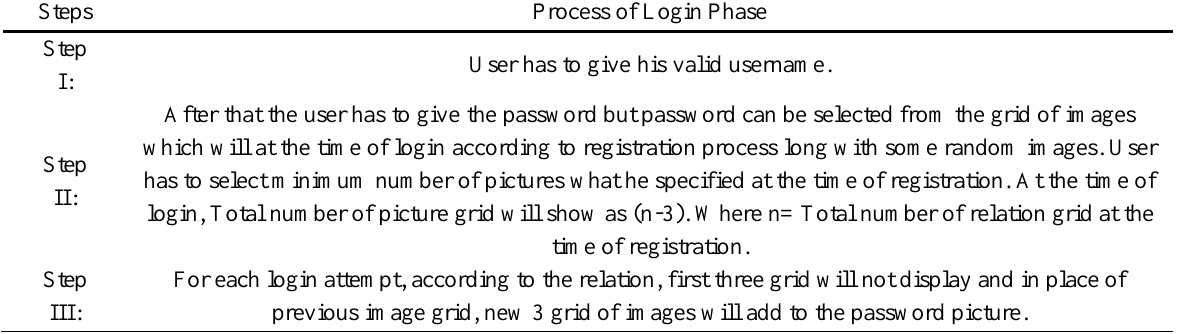
Table 2. Process of login